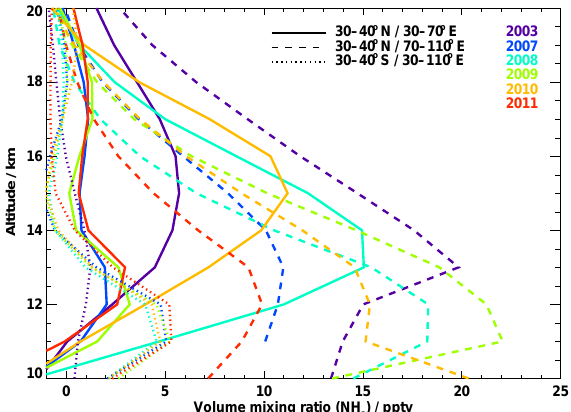
Figure 6. Mean profiles of NH 3 from MIPAS within the geograph- ical range noted in the figure legend during June, July, and Au- gust of each year. Solid: western part; dashed: eastern part of the Asian monsoon; dotted: reference profiles outside the monsoon in the Southern